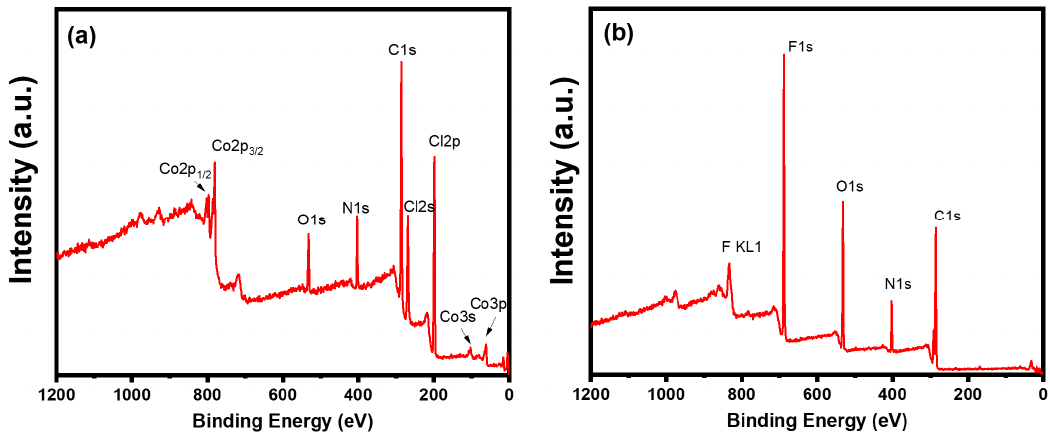
Figure 3. XPS spectra of ( a ) [Me 4 N] 2 CoCl 4 and ( b ) isolated pink solid from [Me 4 N] 2 CoCl 4 -catalyzed reaction.